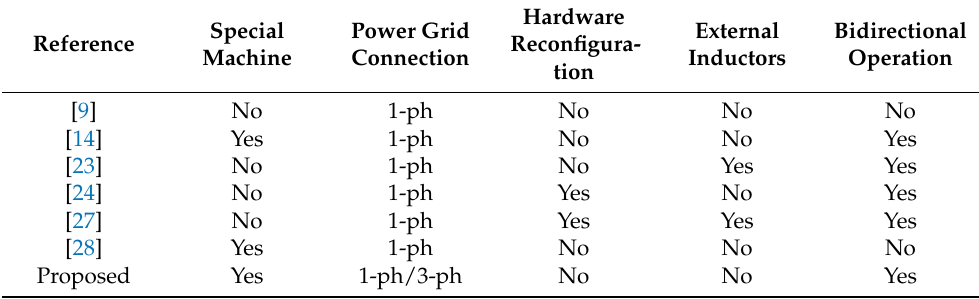
Table 1. Comparison of the analyzed unified power converters for motor drive and slow battery charging for an